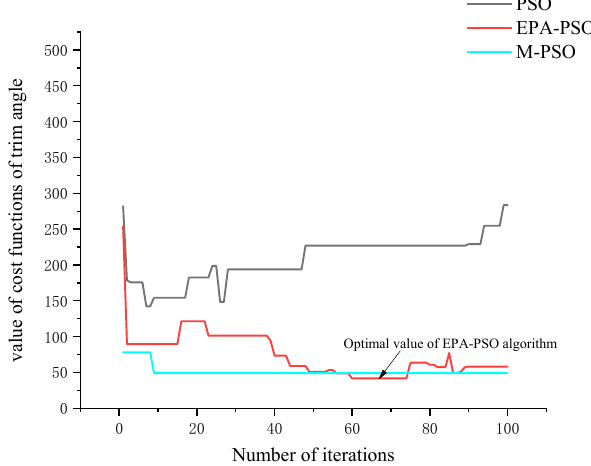
Figure 18. Numerical comparison of cost functions of radius of gyration after 500 iterations.